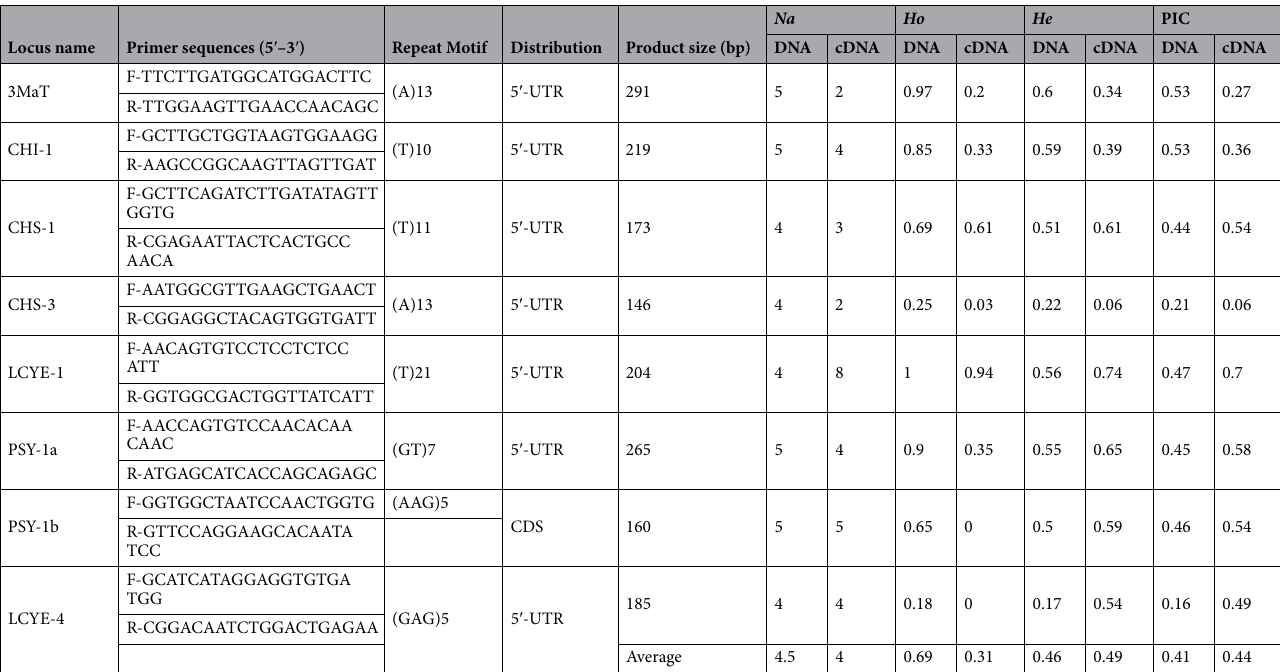
Table 3. List of primer pairs and genetic diversity information. Na Allele of number, Ho Observed heterozygosity, He Expected heterozygosity, PIC polymorphism information